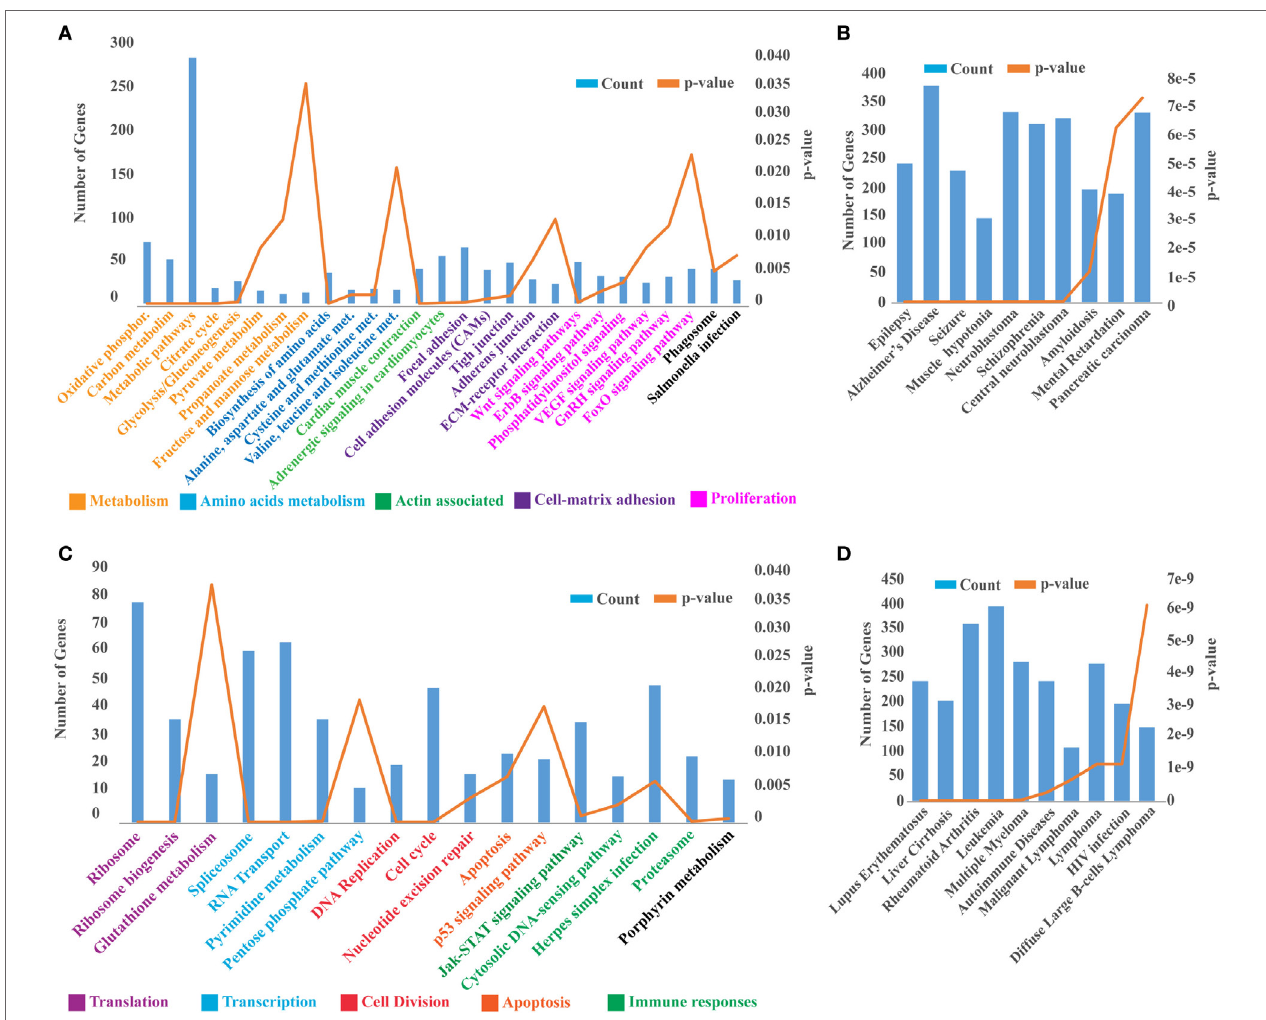
FigUre 5 | Functional annotation of pathways and disease modulated during infectious pancreaticc necrosis virus infection. (a) Functional enrichment analysis displaying the biological pathways enriched by the set of downregulated genes, (c) and upregulated genes. (B) Top 10 disease enriched by the set of downregulated genes, (D) and upregulated genes. Biological pathways were manually group and colored by biological